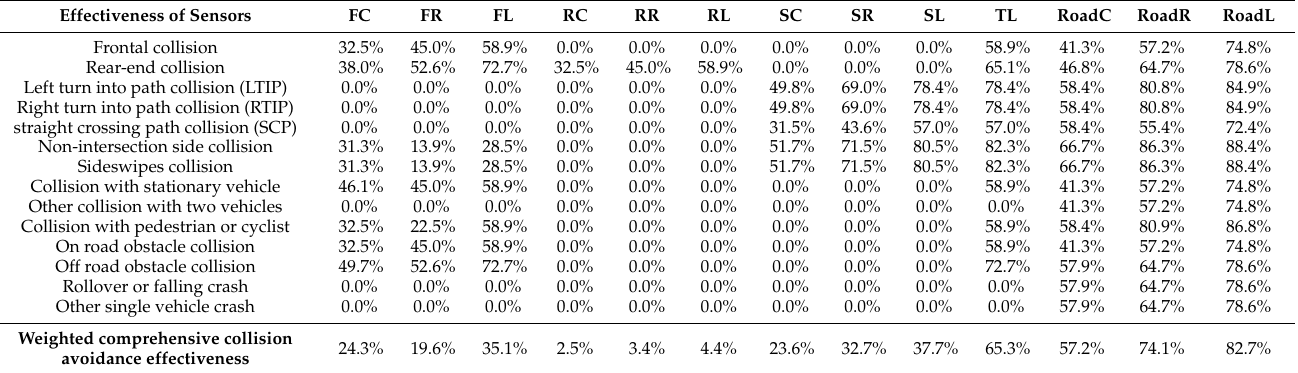
Table A3. Avoidance effectiveness of different “atomic” technologies in various types of accidents. Effectiveness of Sensors Frontal